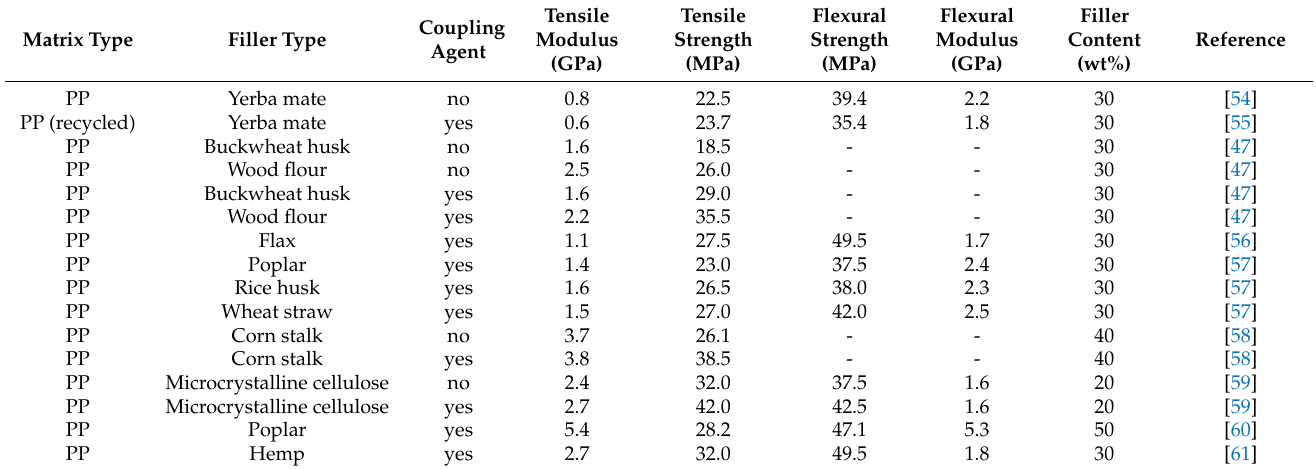
Table 7. Summary of mechanical properties of polymer matrix composites reinforced with natu- ral